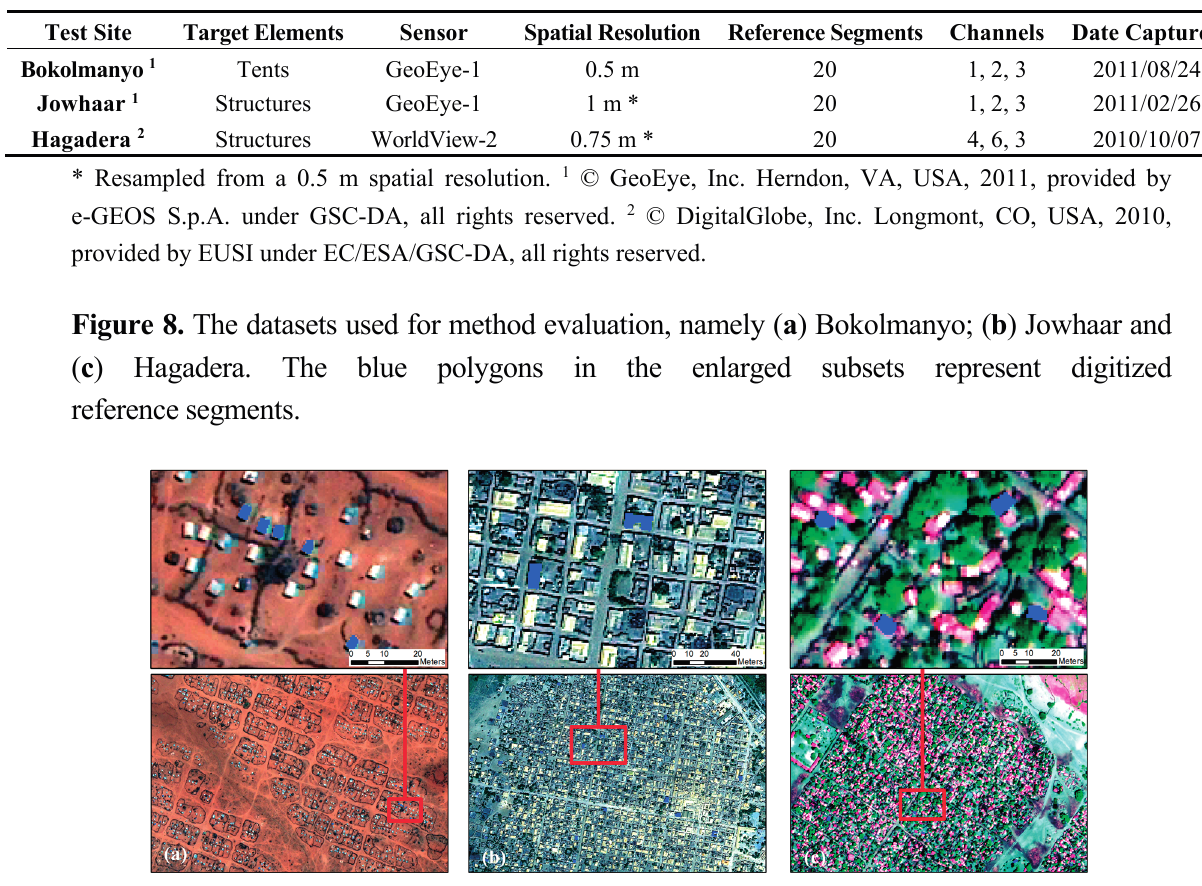
Table 2. Metadata of the datasets used.